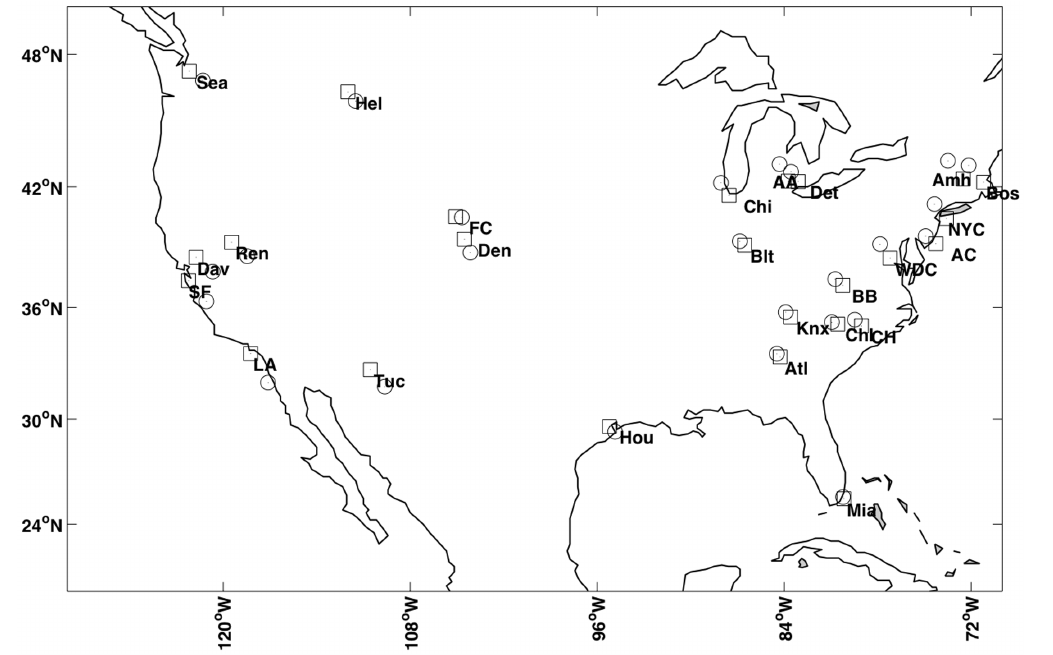
Figure 6. A visualization of the city-data that was updated by a parametric version of the cognitive feedback plotted in Figure 5B. The updated locations of the cities were stretched and rotated to overlay on a map of the United States. The symbols % and 0 mark true and projected city coordinates by WMDS- V2PI. The estimated and true city coordinates are close.